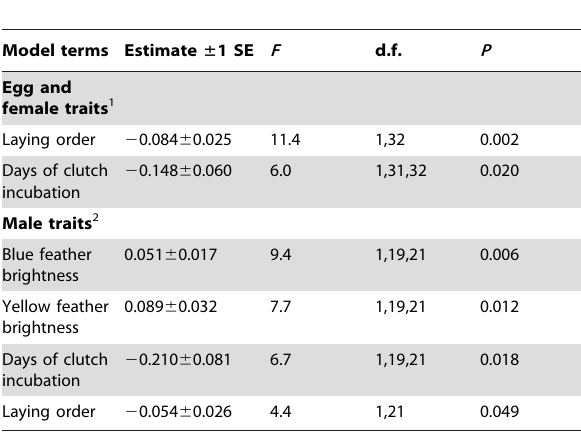
Table 3. Yolk carotenoid concentration of blue tit eggs in relation to egg, female, and male traits.